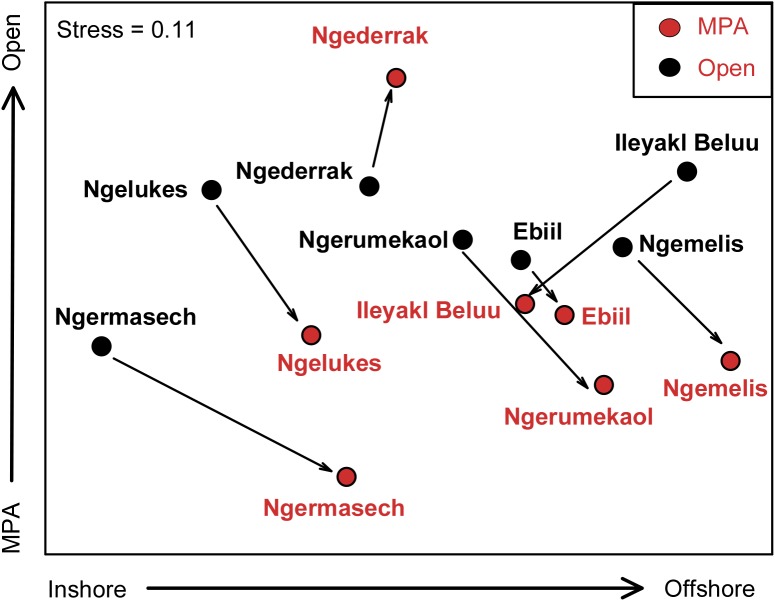
Nonmetric multidimensional scaling plot of mean fish biomass for each MPA and adjacent open areas.Arrows denote the direction and magnitude from open area to MPA in ordination space. Stress = 0.11.